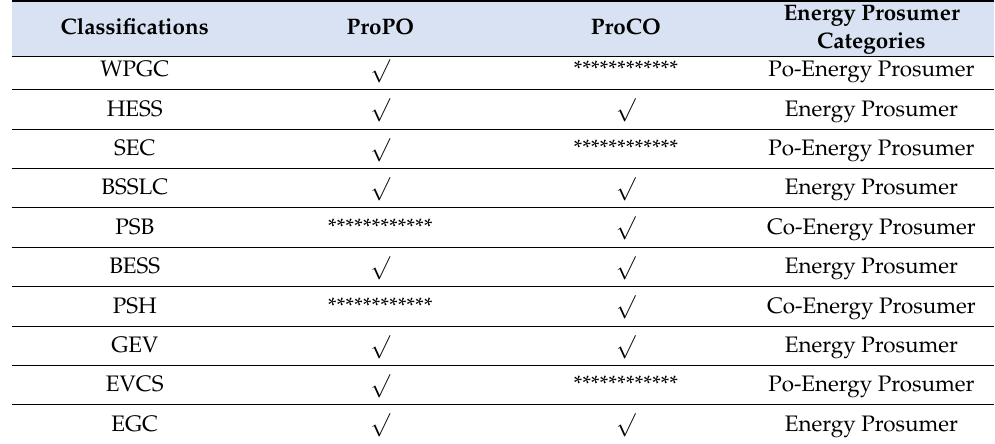
Table 3. Energy prosumer classifications.